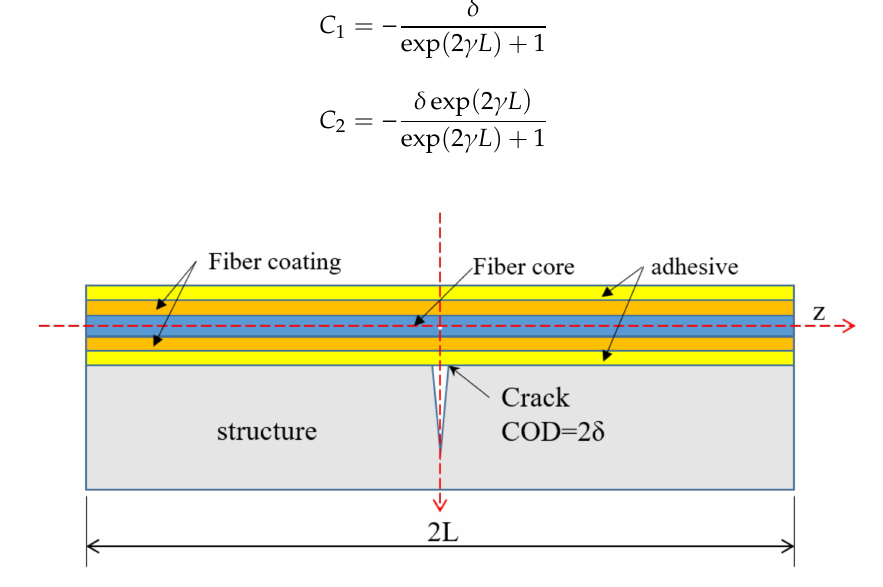
Figure 5. Illustration of strain field of fiber with a structural